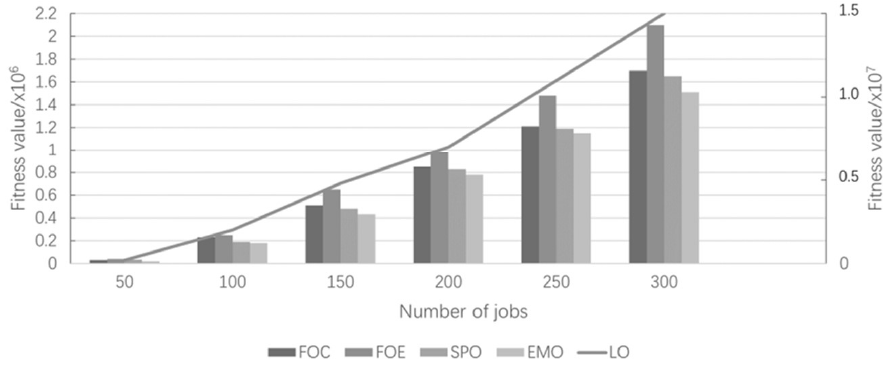
Figure 4. The fitness values of PSO task scheduling algorithms.